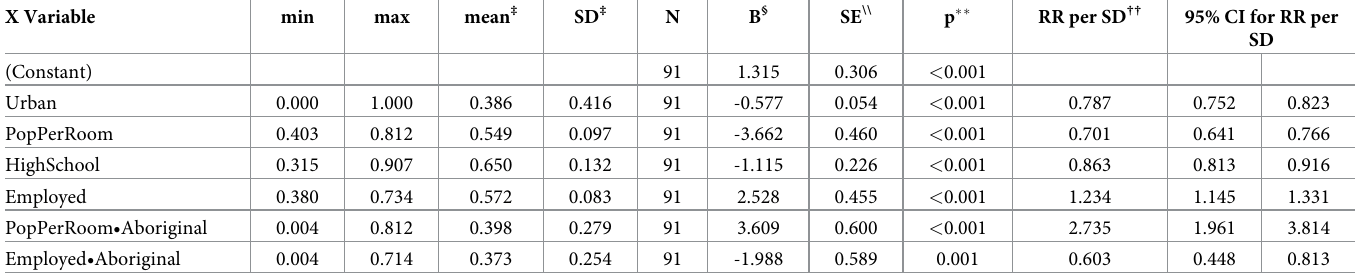
Table 8. Ecologic analysis (cid:3) of risk of hospitalization due to unintentional transport injury among Health Service Delivery Area Population Groups in British Columbia, 1999–2008†. X